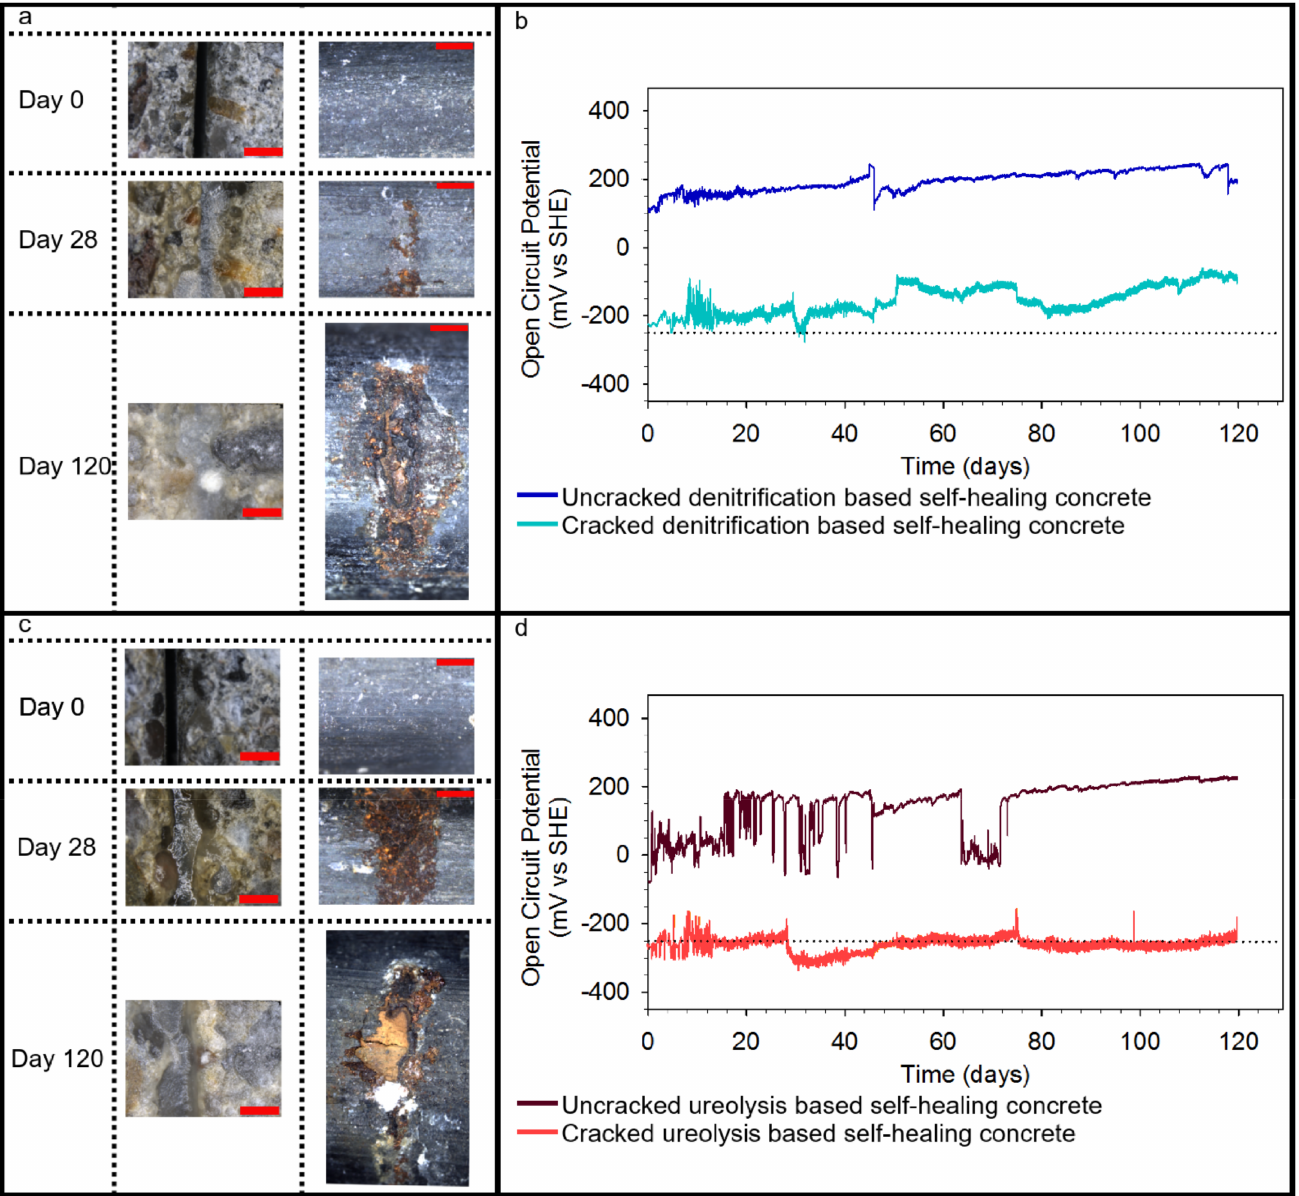
Figure 4. Revealing the simultaneous corrosion inhibition function of denitrification-based microbial self-healing concrete by comparing the evolution of 300 µ m wide cracks, embedded steel rebar surfaces and the open circuit potentials (OCP) of the rebars ( a , b ) in denitrification based microbial self-healing concrete; and ( c , d ) in ureolysis based microbial self-healing concrete. The dashed horizontal line ( ··· ) represents the critical OCP value ( − 250 mV) for Fe in the tested Cl − solution. Scale bars represent 1 mm (based on Ersan et al.